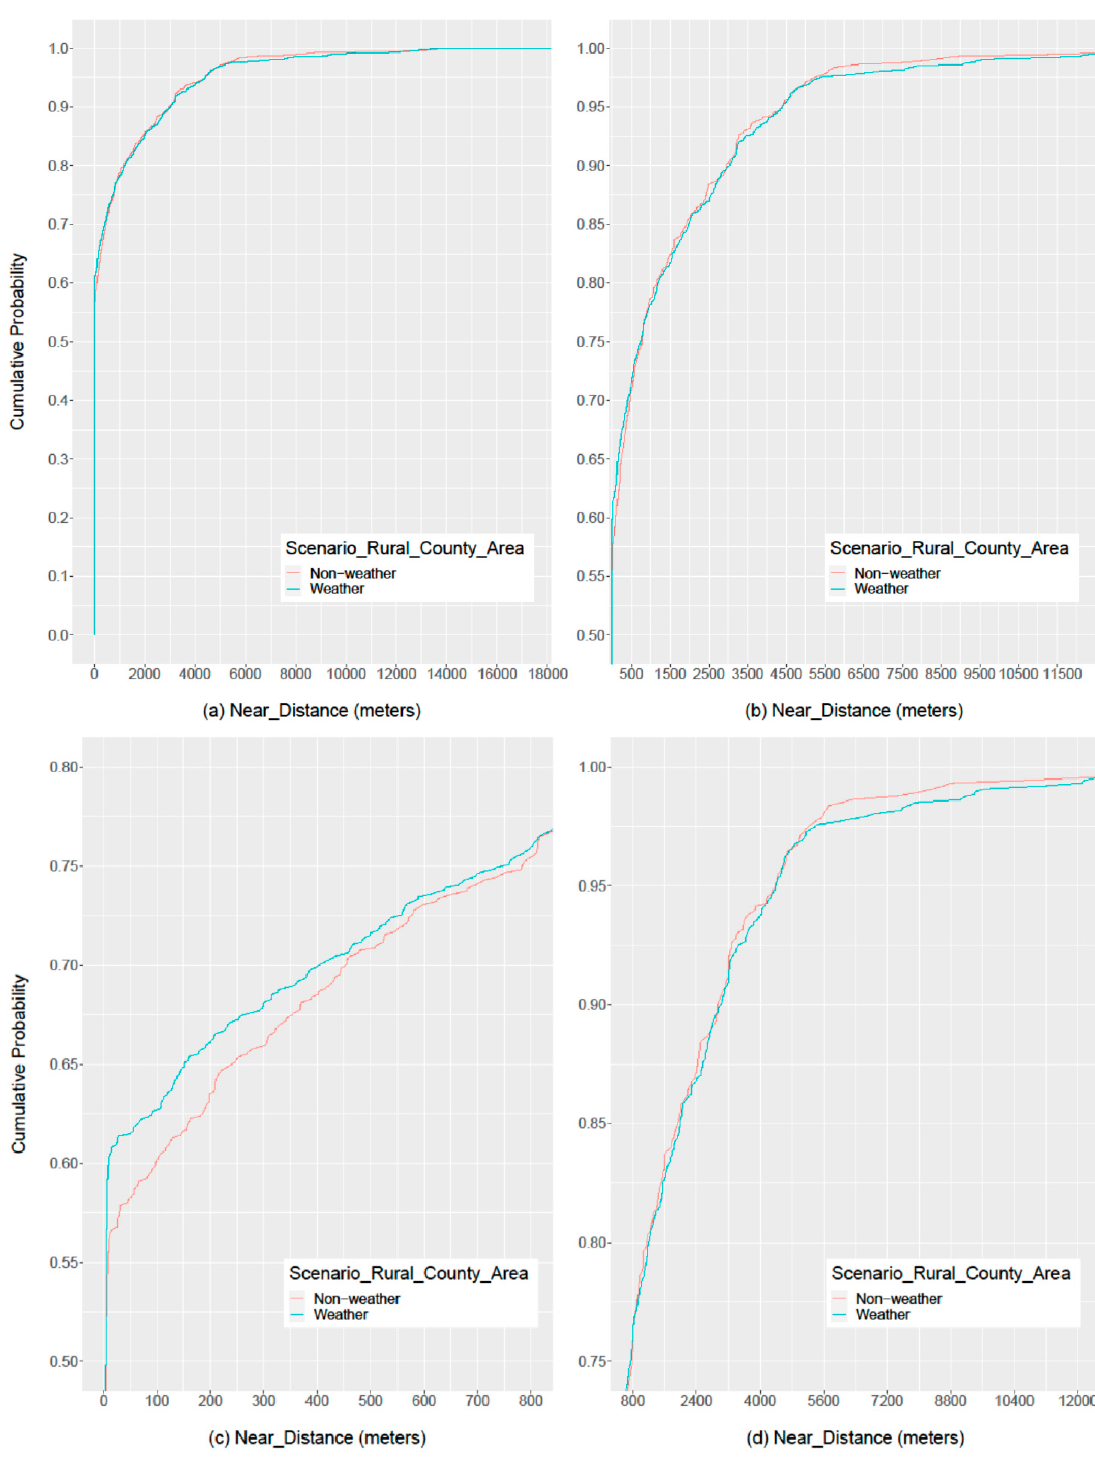
Figure 4. Nearest distance to adjacent highways for rural counties. ( a ) Overall display; ( b ) zoom-in display 1; ( c ) zoom-in display 2; ( d ) zoom-in display 3.